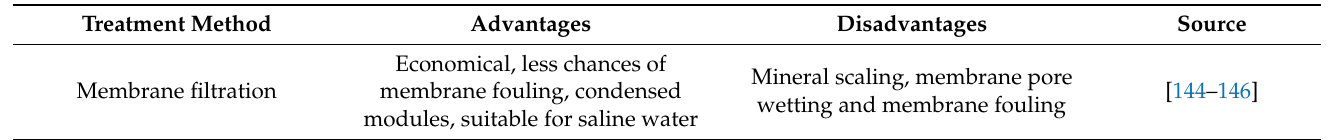
Table 9. Summary of advantages and disadvantages all methods of PAHs removal from produced